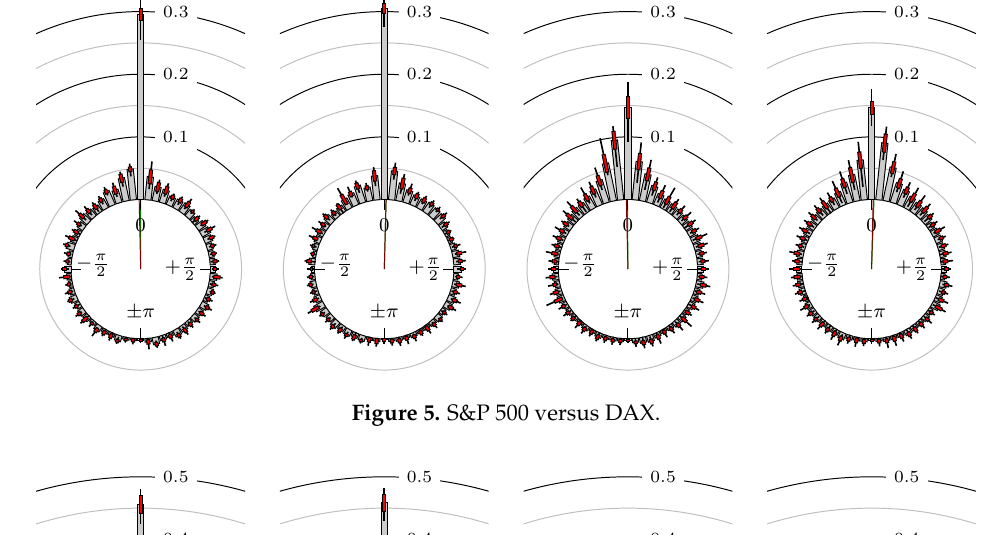
Figure 5. S&P 500 versus DAX.